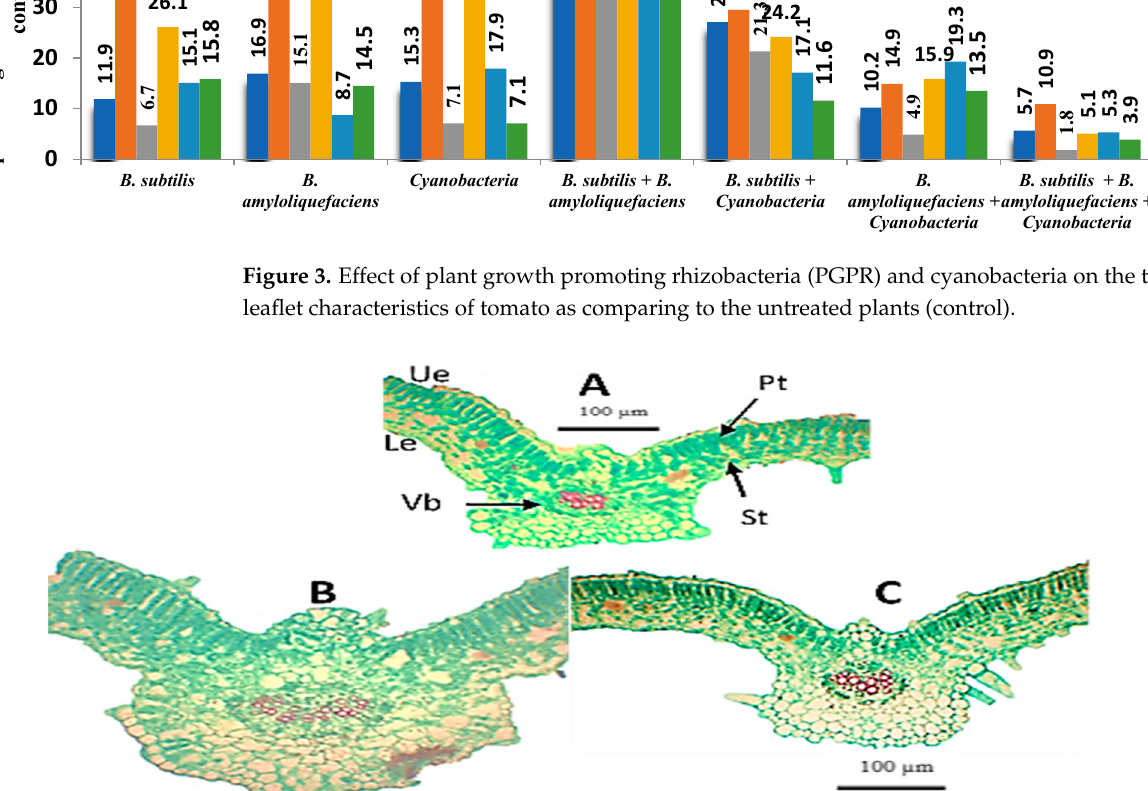
Figure 4. ( A – C ). Microphotographs of cross- sections through the blade of the terminal leaflet of the compound leaf developed on the median portion of the main stem of tomato plant. ( A ) Untreated plant (control), ( B ) from plant grown under B. subtilis + B. amyloliquefaciens , and ( C ) from plant grown under B. subtilis + B.amyloliquefaciens + Cyanobacteria . Abbreviations: Le = lower epidermis; Pt = palisade tissue; St = spongy tissue; Ue = upper epidermis and Vb = vascular bundle. 2.3. Yield Parameters 2.3.1. Productivity Criteria The influence of bacterial inoculation with two PGPR strains ( B. subtilis and B. amyloliquefaciens ) and cyanobacteria on the yield parameters of tomato plants is presented in Table 1. As shown by the results, in the first season, the effect of inoculation varied among the measured parameters. As shown in the results, the smallest value of plant height, 77 cm, was recorded for the uninoculated treatment, which was